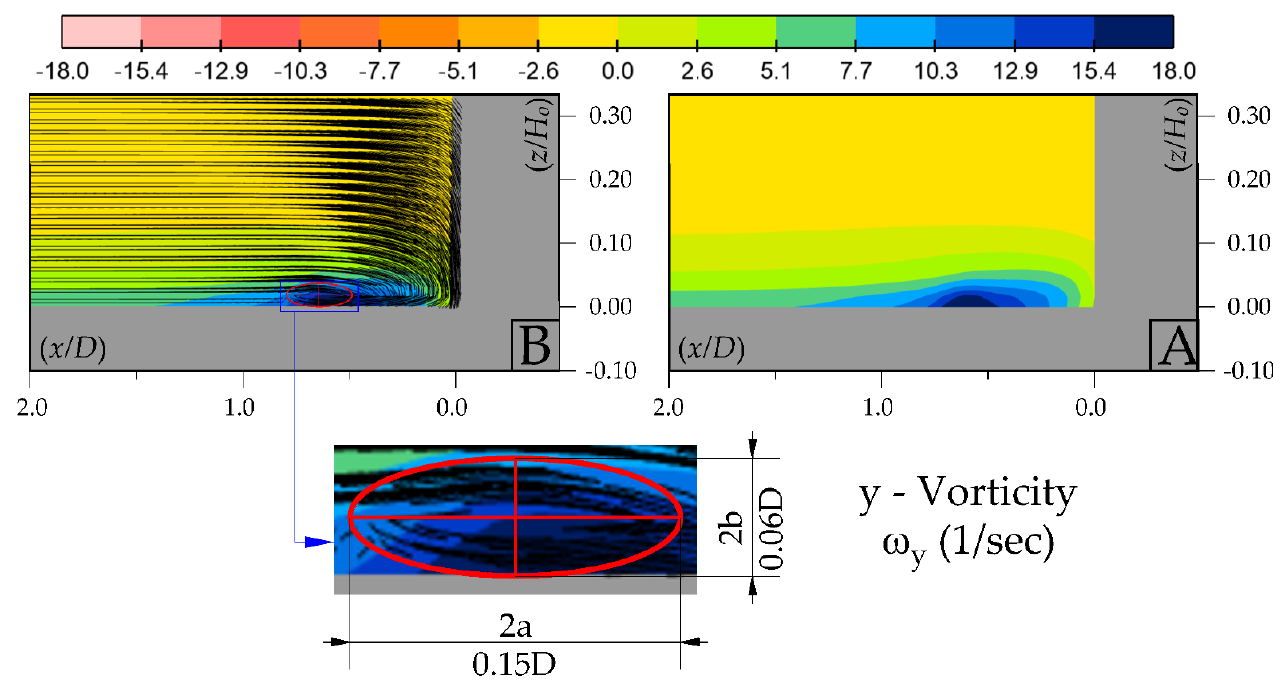
Figure 14. ( A ): Y-vorticity (𝜔 𝑌 ) contours, ( B ): approximate boundaries of the HV vortex at flat-bed conditions.